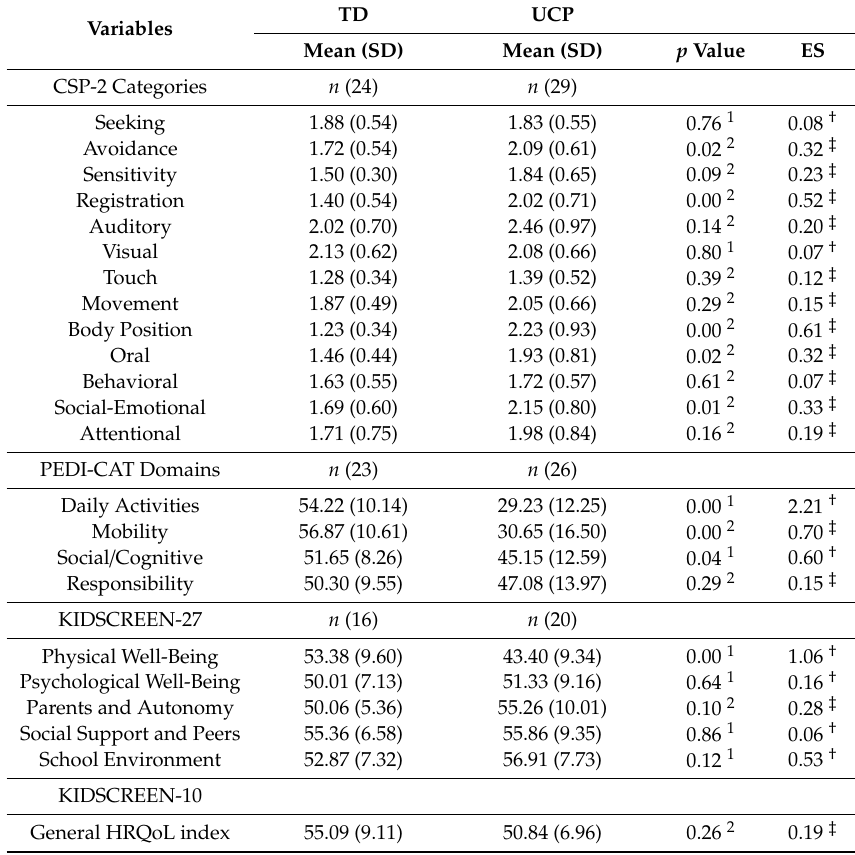
Table 2. Di ff erences in CSP-2, PEDI-CAT and Kidscreen-27 and -10 between groups. Table 2. Differences in CSP-2, PEDI-CAT and Kidscreen-27 and -10 between groups.